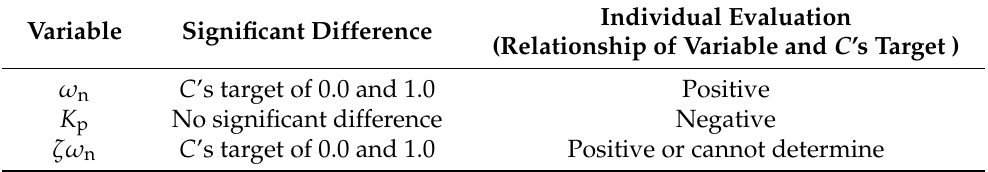
Table 4. The summary of each